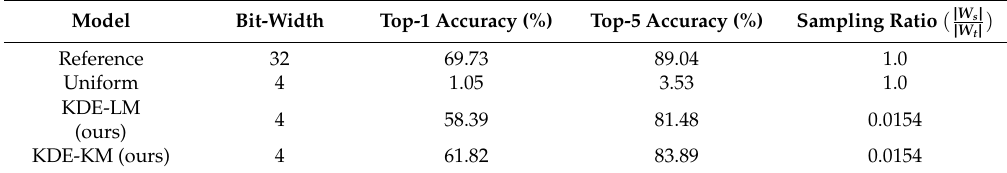
Table 3. Performance comparison of ResNet-18